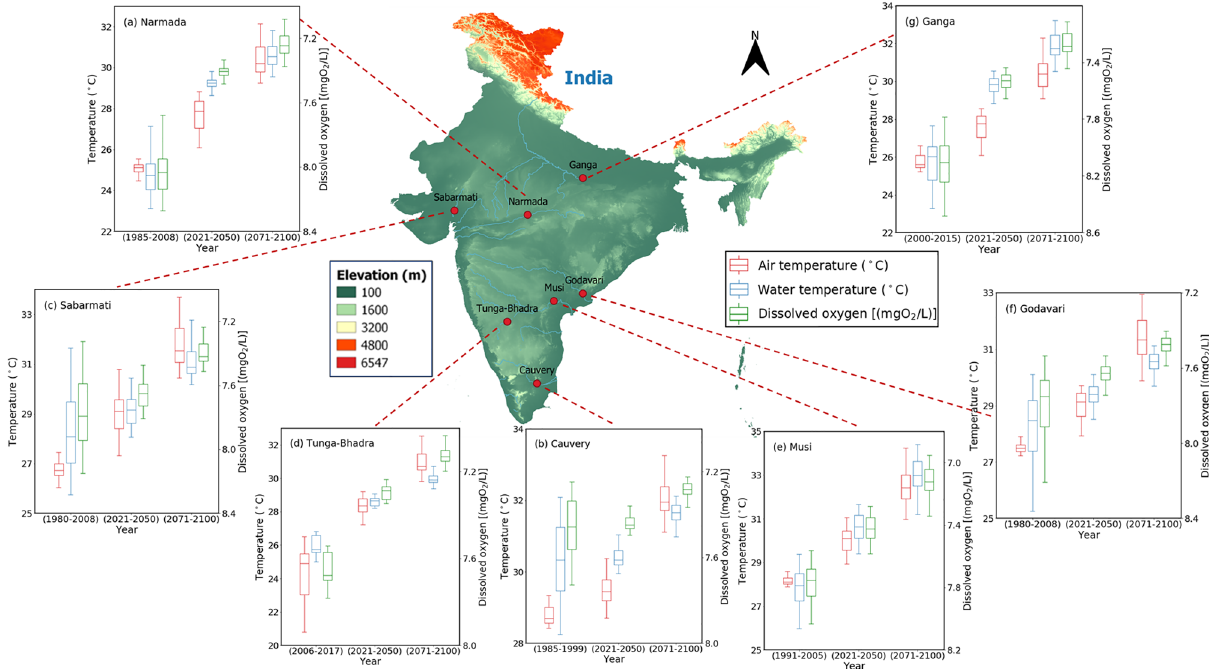
Figure 4. Boxplots represent the Representative Concentration Pathway (RCP) 8.5 experiments air temperature (°C) values; projected water temperature (°C) and dissolved oxygen (mgO 2 /L) values of historical, 2021–2050, and 2071–2100 for seven Indian catchments. The map was created using QGIS v3.4.14 (https:// qgis. org), Python v3.7.4 (https:// www. python. org), and post-processed with PowerPoint v2018 (https:// micro soft. com).